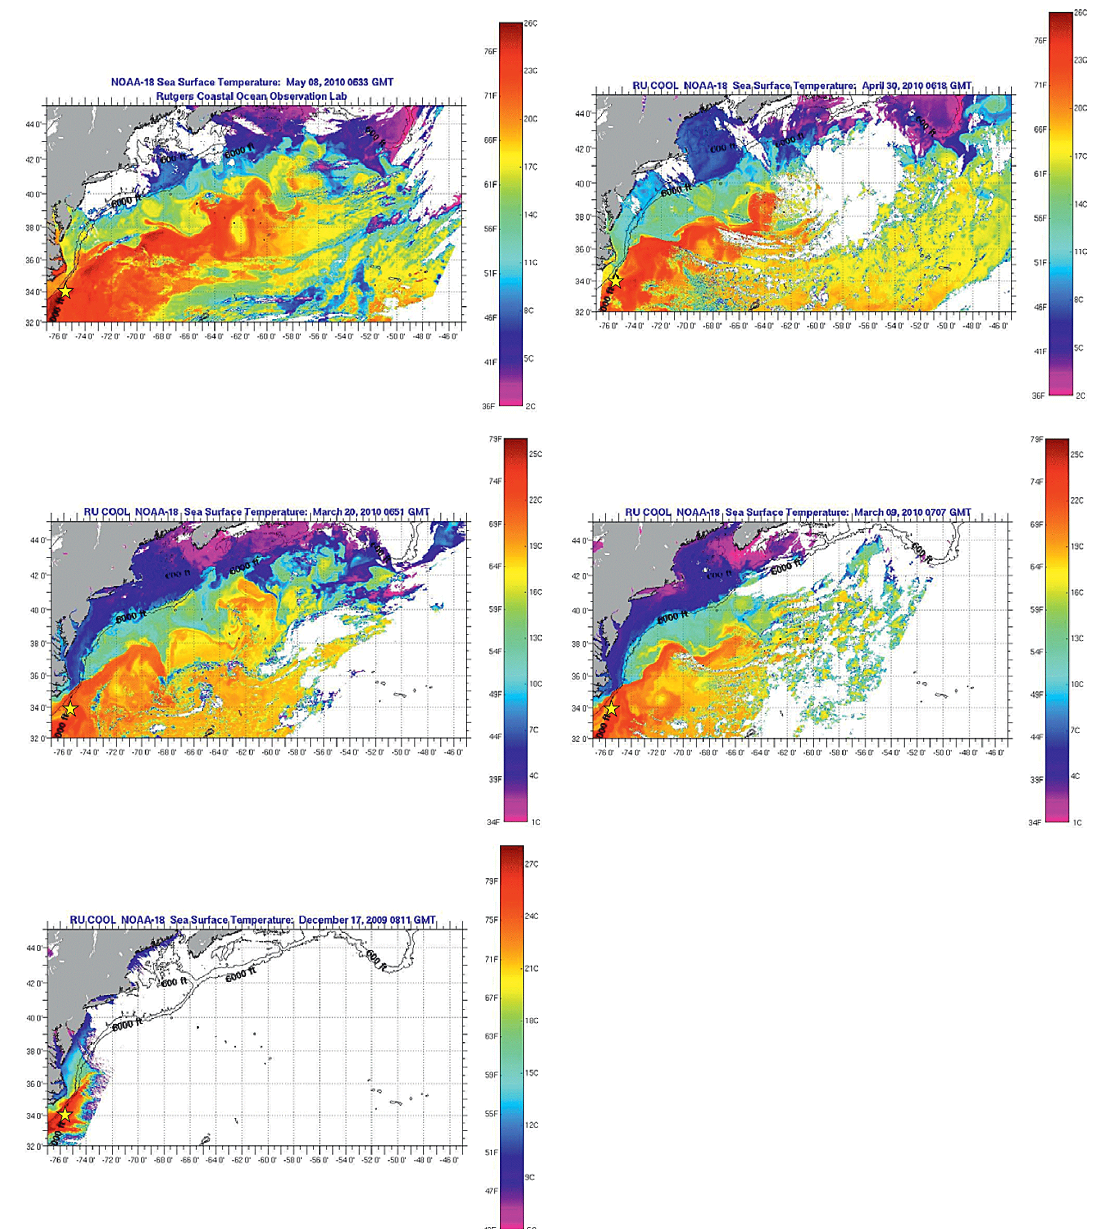
Fig. 12. SST satellite images of sea-surface temperature distribution in the NW Atlantic on 17 December 2009, 9 and 20 March, 31 April and 8 May 2010 (http://marine.rutgers.edu/mrs/sat_data/). The position of the Gulf Stream and its influence on the study area off central North Carolina is clearly